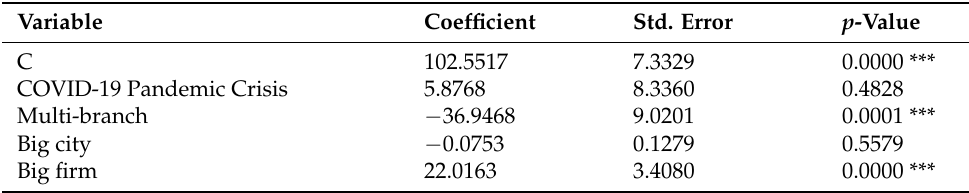
Table 5. The results of the fourth research model.